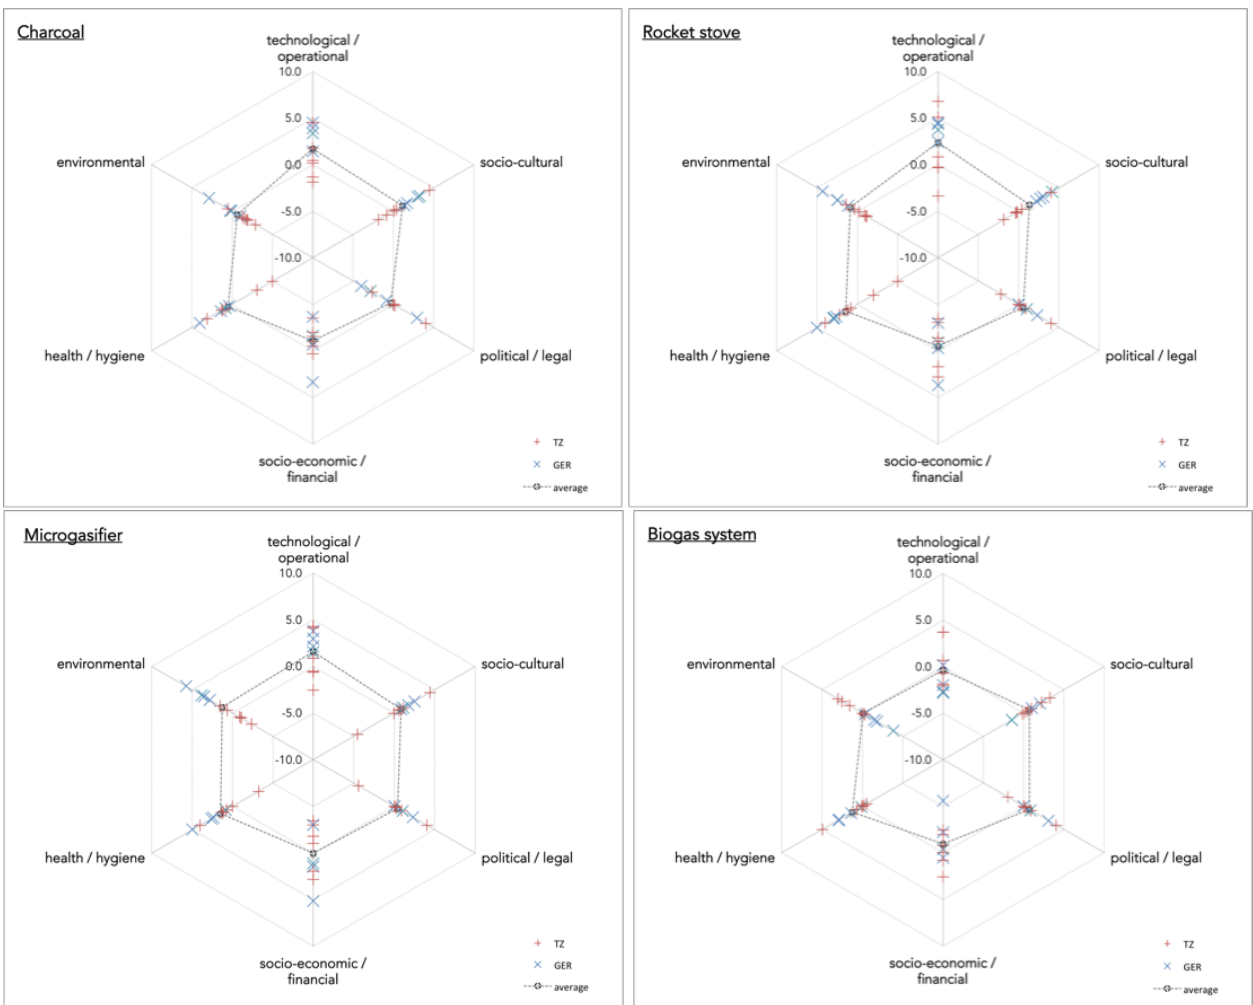
Figure 5. Colour-coded scatter plot for the four cooking alternatives analysed (charcoal stove, rocket stove, microgasifier, biogas system) indicating the assessment results of Tanzanian (red) and German participants (blue) alongside the mean of all participants (grey). Results are shown on the level of the six main-criteria. Values range from − 10 to + 10 (cf. Table